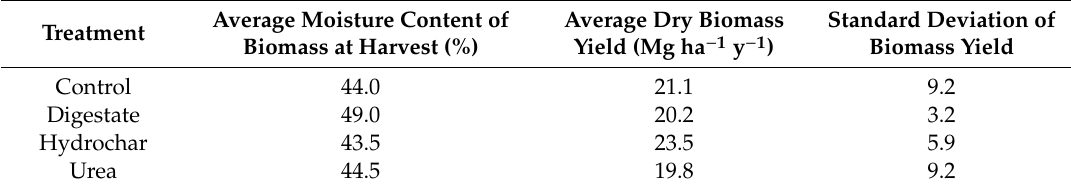
Table 1. Summary of average miscanthus biomass yields for the growing season of 2018 from subplots treated with digestate, hydrochar, urea, and a control treatment (with standard deviations) (n = 4 for all measurements). Average dry biomass yield was calculated by averaging biomass yield in four blocks (plots) for each treatment *.